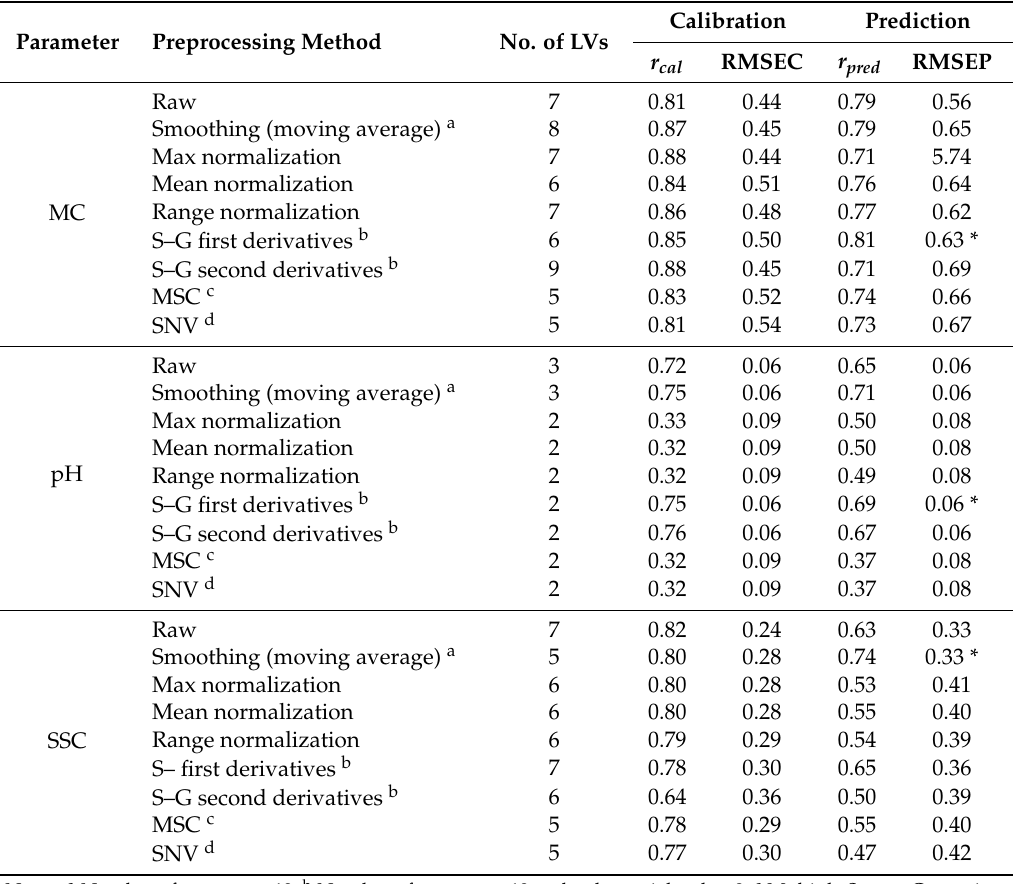
Table 2. Partial least squares regression results for the prediction of moisture content (MC), pH, and soluble solid content (SSC) for intact tomatoes with different preprocessed